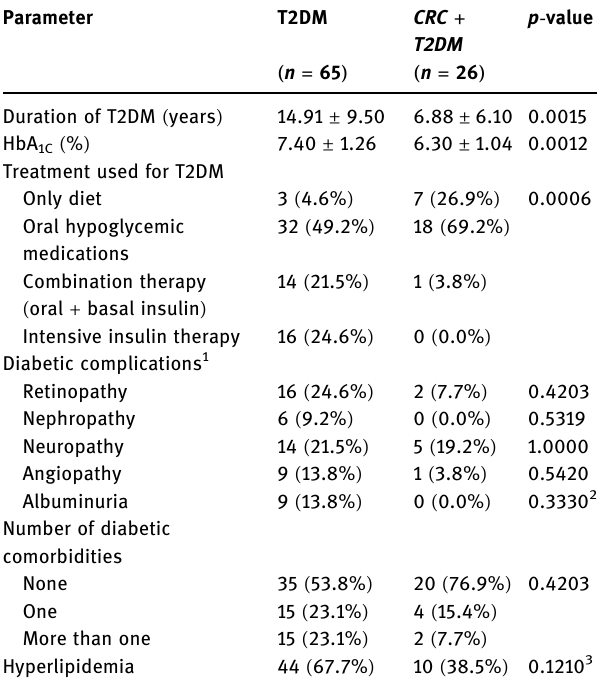
Table 3: Diabetes - related parameters of T2DM and CRC + T2DM